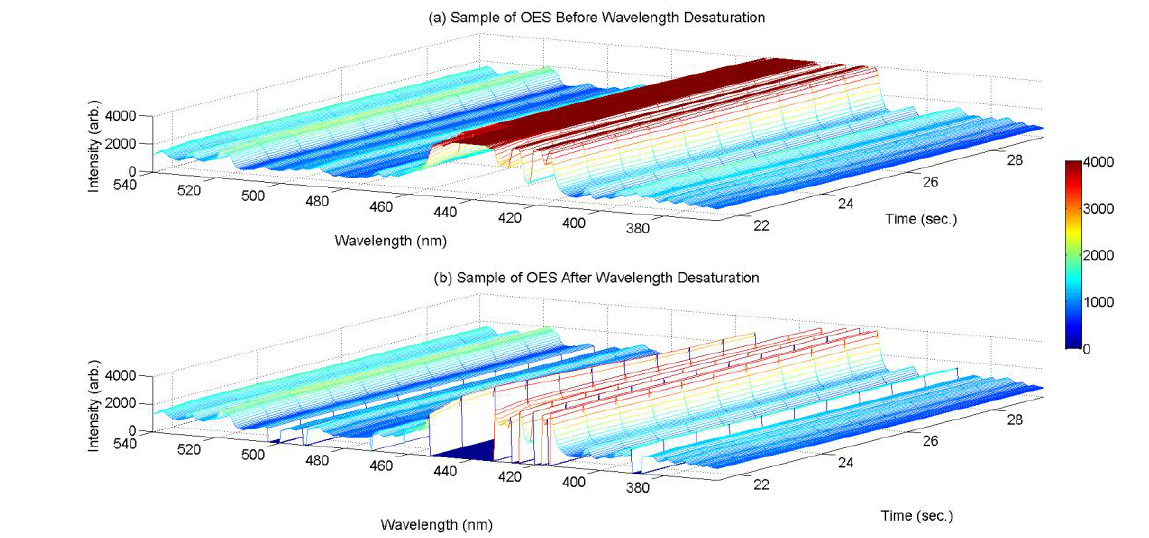
Figure A1. Sample of OES measurements ( a ) before and ( b ) after